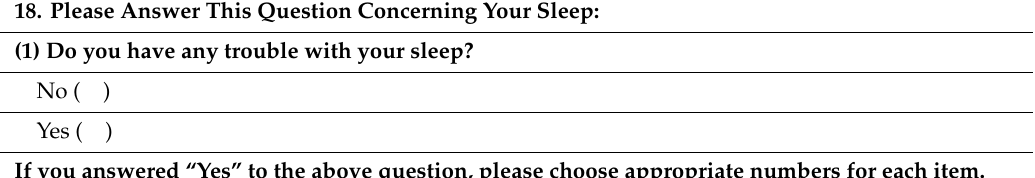
Table 1. Questions used to define